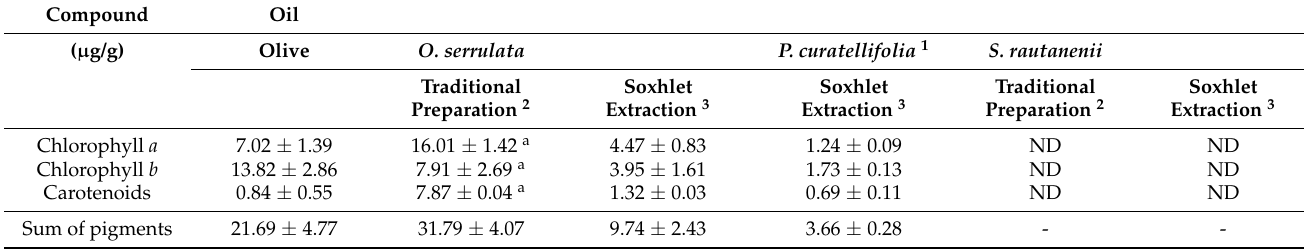
Table 4. Pigment content in the analyzed oils.